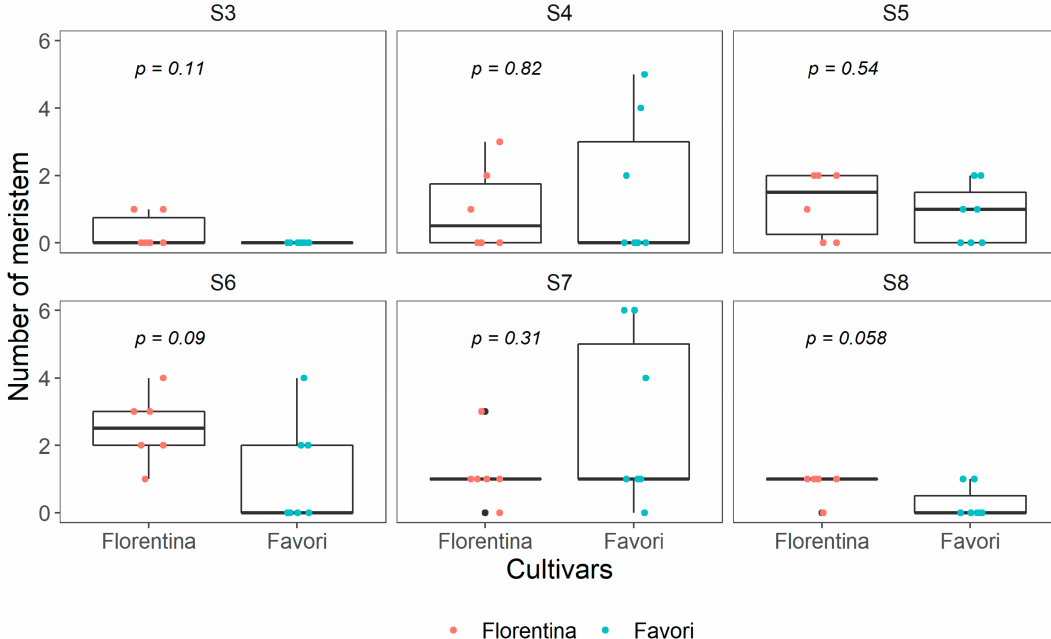
Figure 2. Boxplot of number of meristems at each developmental stage (S3–S8) in ‘Florentina’ and ‘Favori’ strawberry plants at start of experiment (W0), N = 7, where any bud below S4 was pooled as vegetative and categorized as S3. The p -value is adjusted using pairwise Kruskal − Wallis